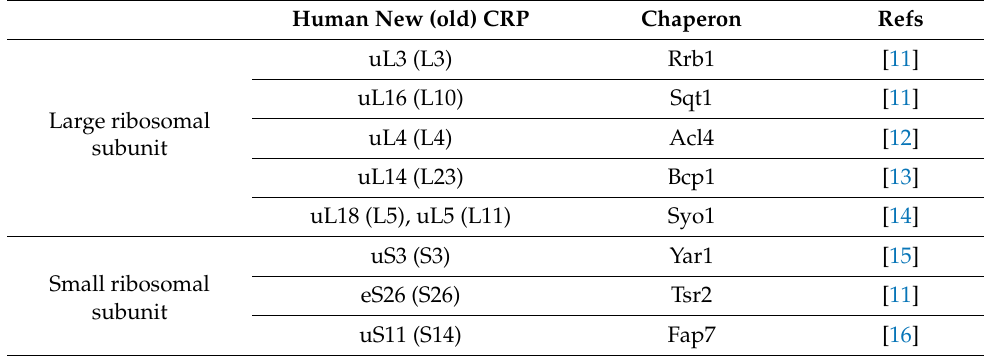
Table 1. Dedicated CRP